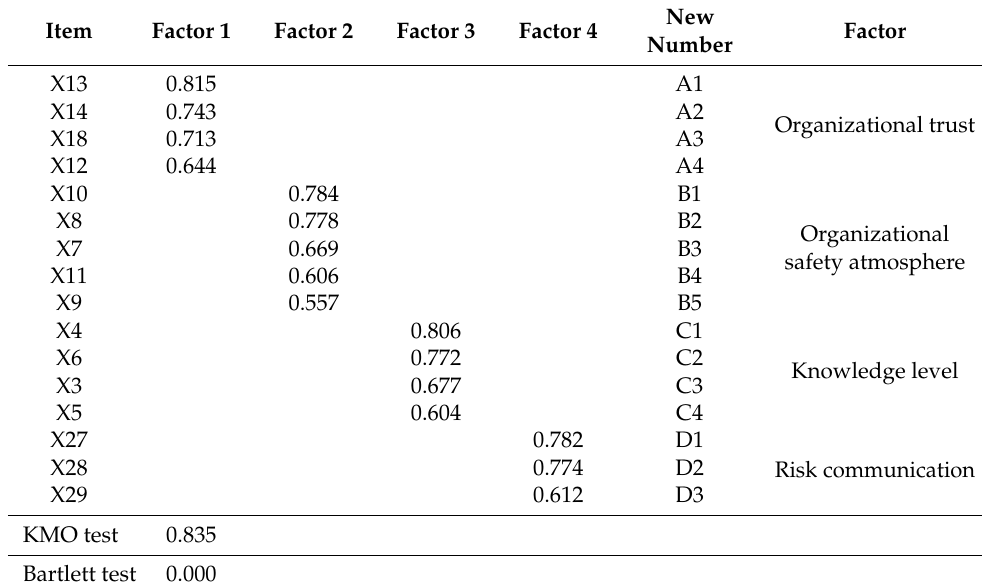
Table 1. Exploratory factor analysis summary of miner risk cognitive factors (second survey).